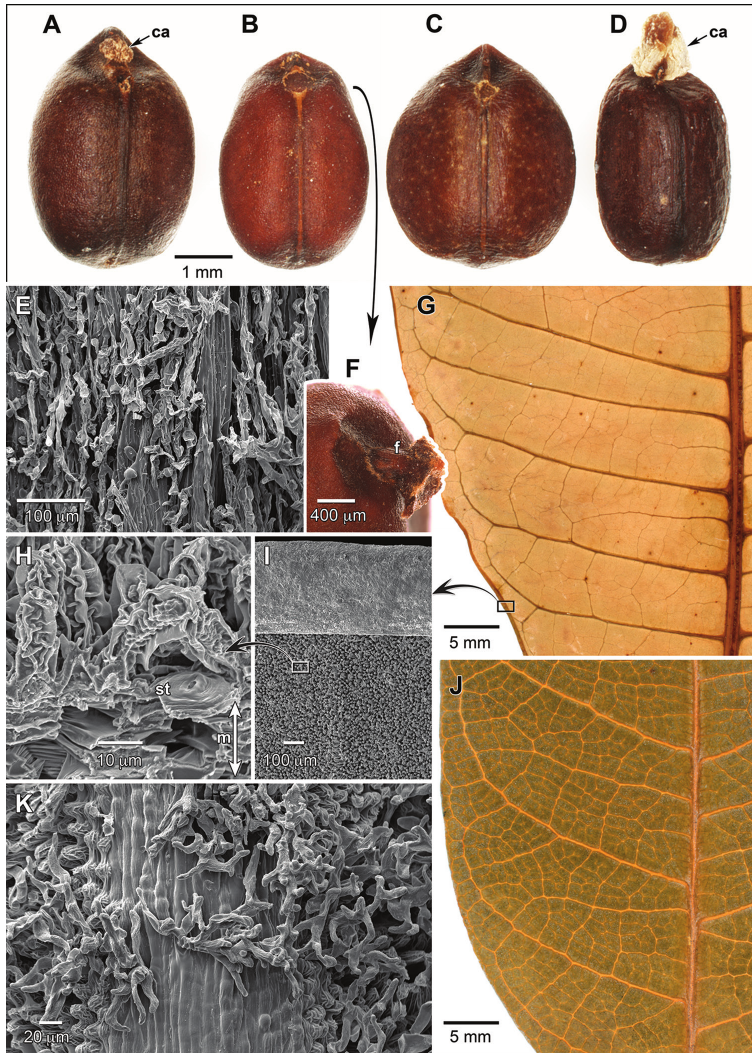
Figure 3. Seeds and surfaces of Dendrothrix . A–D Ventral views of seeds (ca = caruncle) A D . yutajensis B D . condorensis C D . multiglandulosa D D . wurdackii E D . condorensis , inflorescence axis showing den- dritic trichomes F D . condorensis , top of seed showing short funicle (f) and caruncle absence G Abaxial view of D . condorensis leaf H D . condorensis transverse fractured leaf showing abaxial papillae and stomata (st), above intercellular space in the spongy parenchyma (m = mesophyll) I D . condorensis abaxial leaf micropapillae contrasting with smooth revolute adaxial leaf margin at image top J Adaxial view of D . yutajensis leaf K D . wurdackii , abaxial leaf surface along secondary vein showing gradient of micropapillae development at vein edges, and overlying dendritic trichomes. ( A – D, F–G, J imaged with a Olympus DSX100 E, H–I, K imaged with a Zeiss EVO MA15 SEM at 10–12 kV after sputter coating with 25 nm of Au/Pd; SEM samples untreated and directly mounted from dried herbarium specimens. Source: A Nee 31120 , NY; B, F Neill et al. 15750 , MO; C Maguire & Politi 27683 , NY; D Calderón et al. 2682 , US; E, G–I Neill & Quizhpe 14939 , MO; J Amaral 1523 , MO; K Cid Ferreira 5797 ,